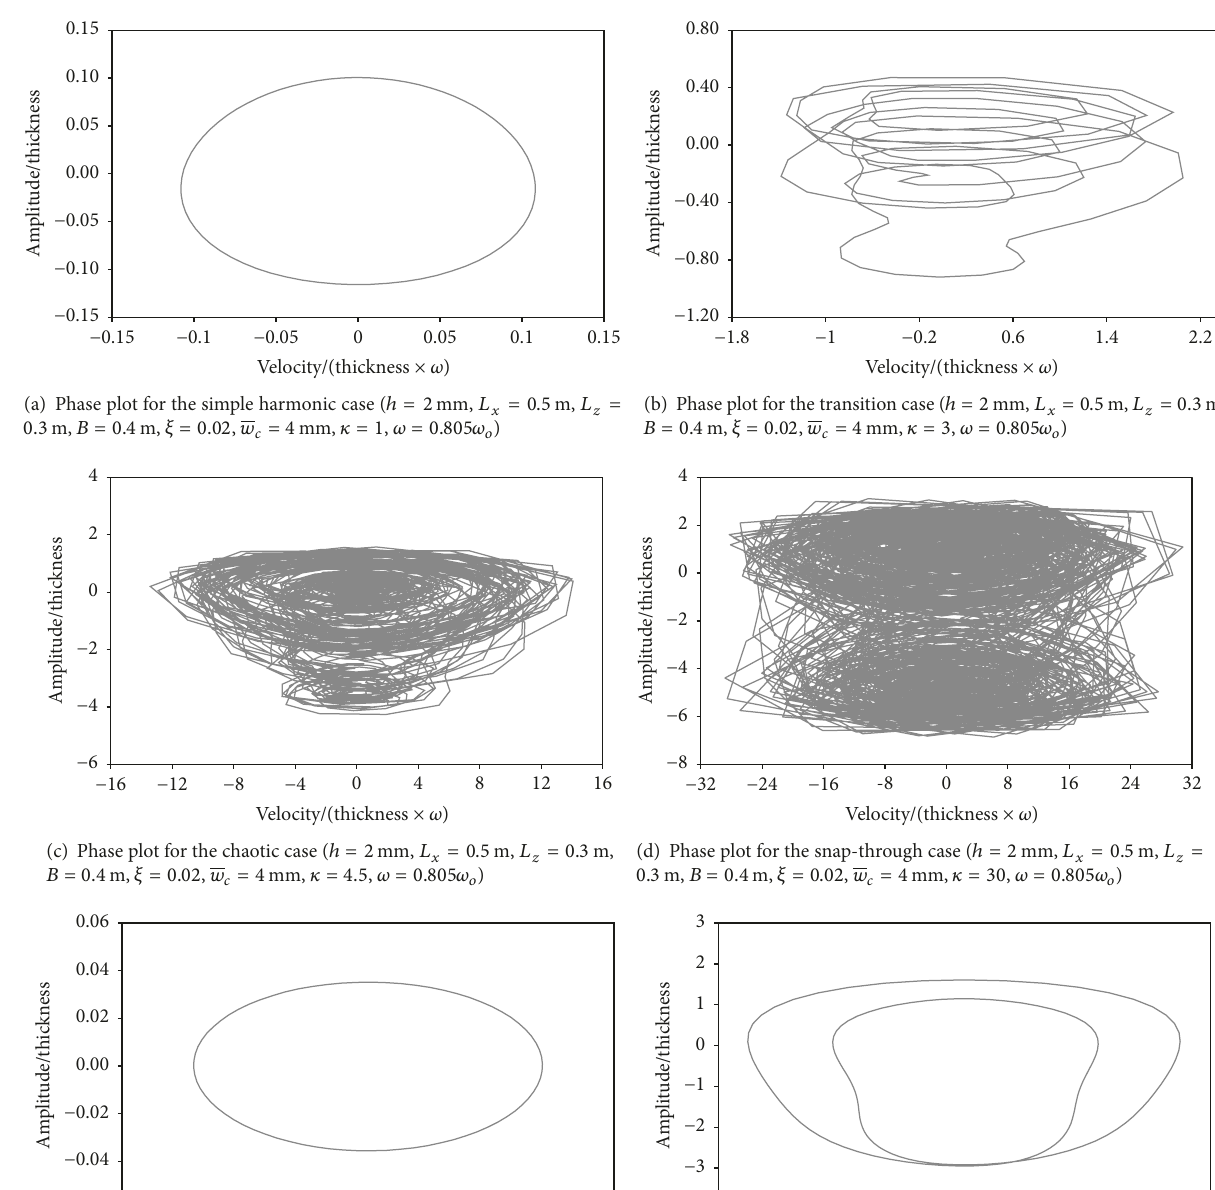
(e) Phase plot for the simple harmonic case ( ℎ = 2 mm, 𝐿 𝑥 = 0.5 m, 𝐿 𝑧 = 0.3 m, 𝐵 = 0.4 m, 𝜉 = 0.02 , 𝑤 𝑐 = 2.5 mm, 𝜅 = 1 , 𝜔 = 3.22𝜔 𝑜 )